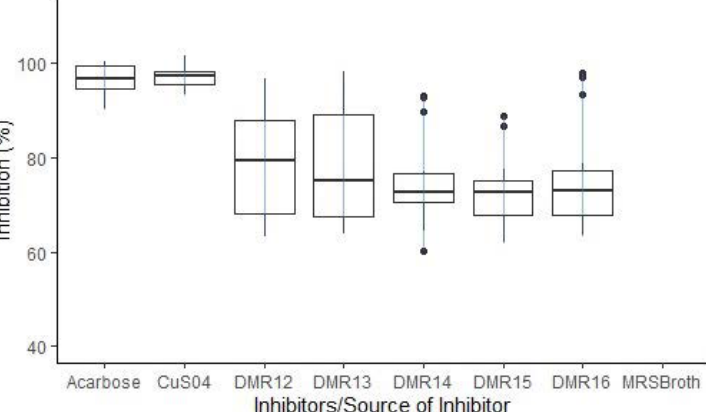
Fig. 2. Boxplot showing the distribution pattern of AAI activities of the inhibitor from different LAB isolates. AAI activities of MRS broth was below 2% and hence not shown in the